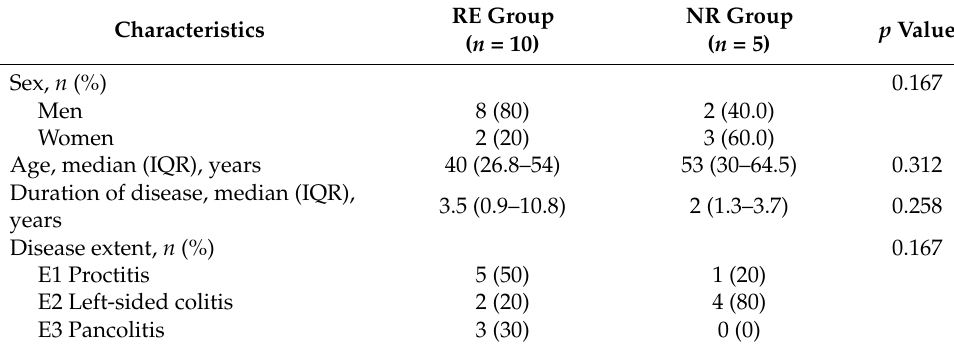
Table 1. Baseline characteristics of the FMT